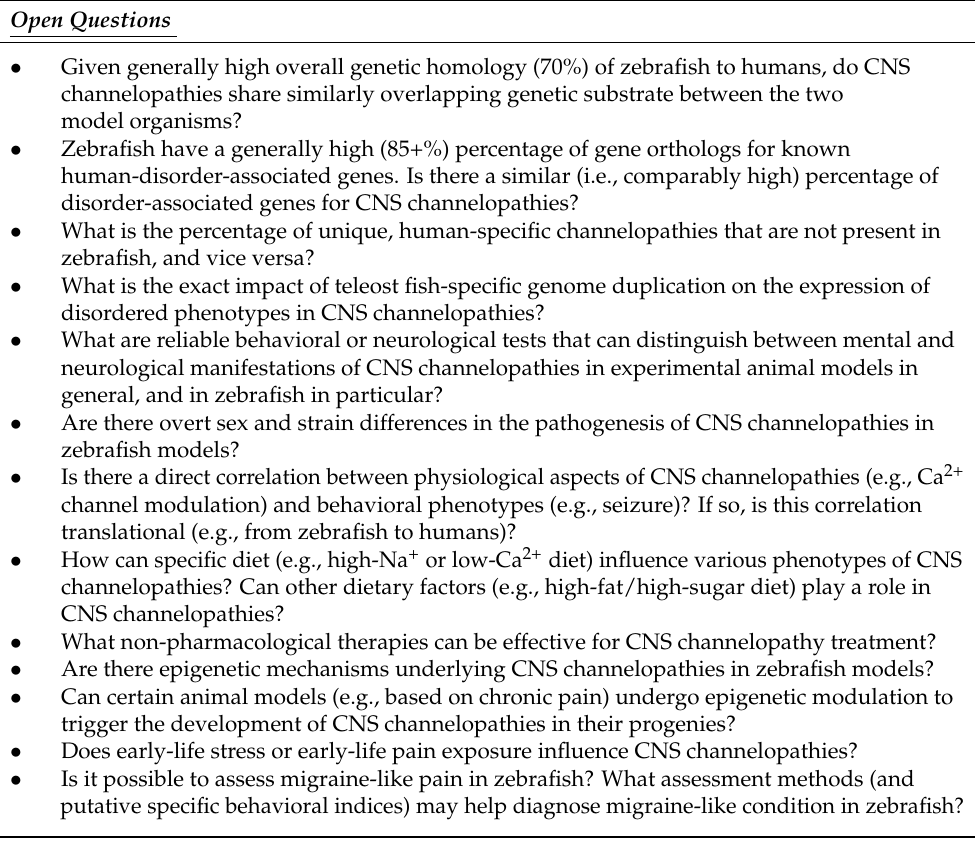
Table 5. Selected open questions related to zebrafish-based modeling of CNS channelopathies. Open